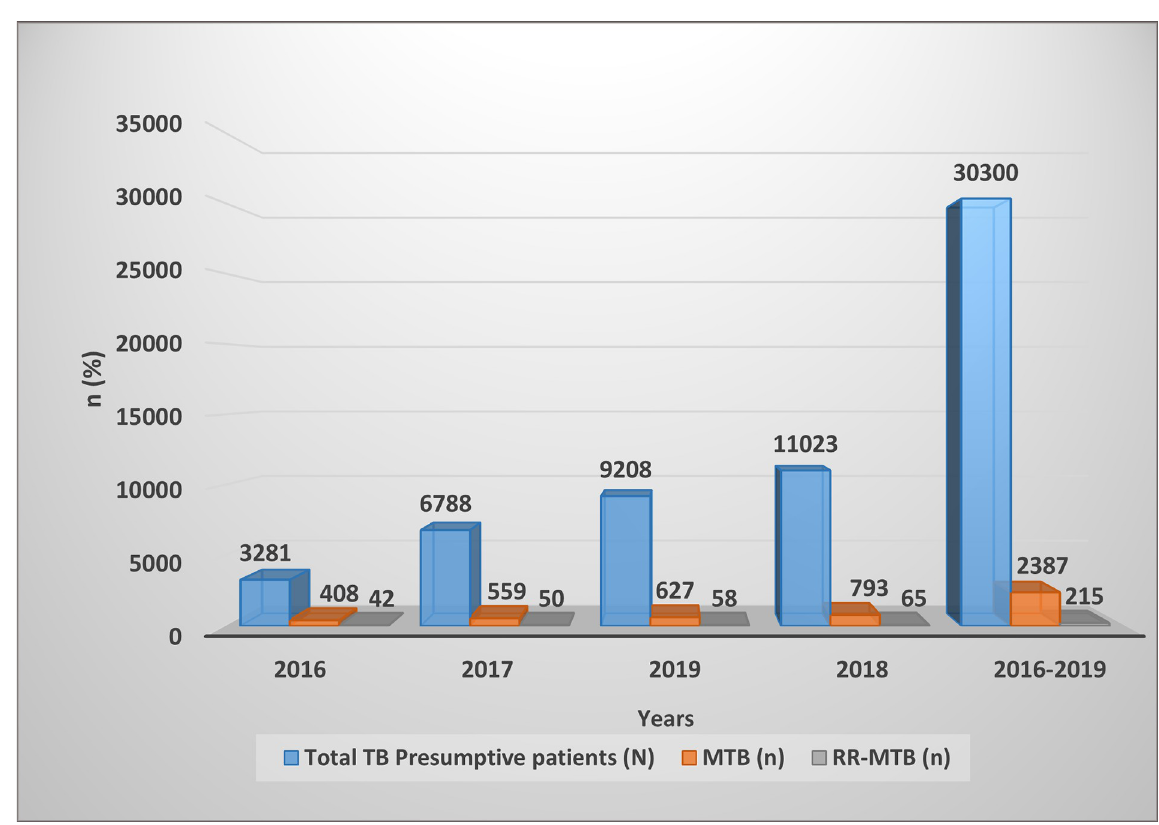
Fig 2. Frequency of MTB and RR- MTB by study